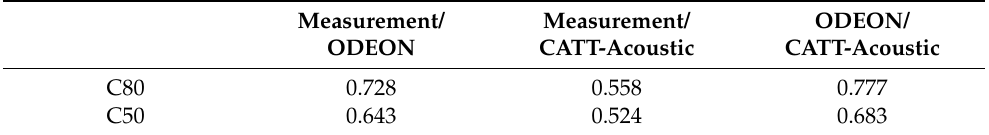
Table 6. Correlations between measurement and simulations for C80 and C50.